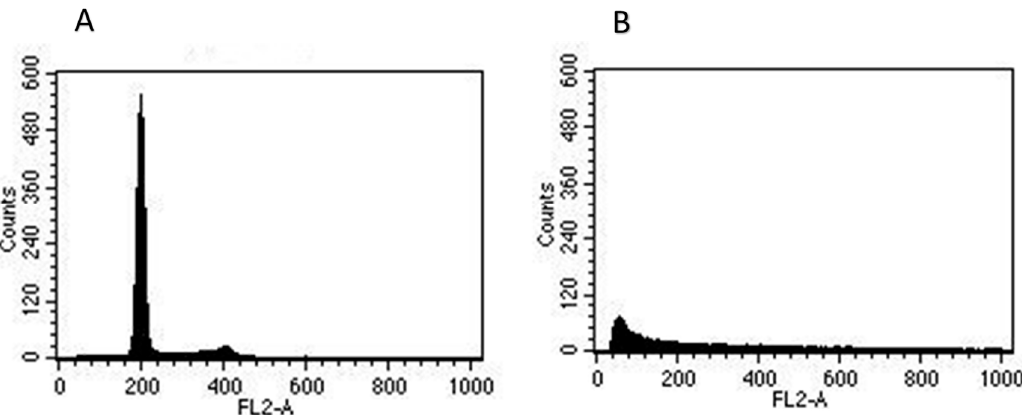
Figure 7. Results of the wash-out experiment: ( A ) SW480, non-treated, the scan shows a regular growing cell culture; ( B ) SW480, wash-out experiment, 48 h after removal of the examined compound; no recovery of cells, main peak in sub-G1 domain indicates cell death.